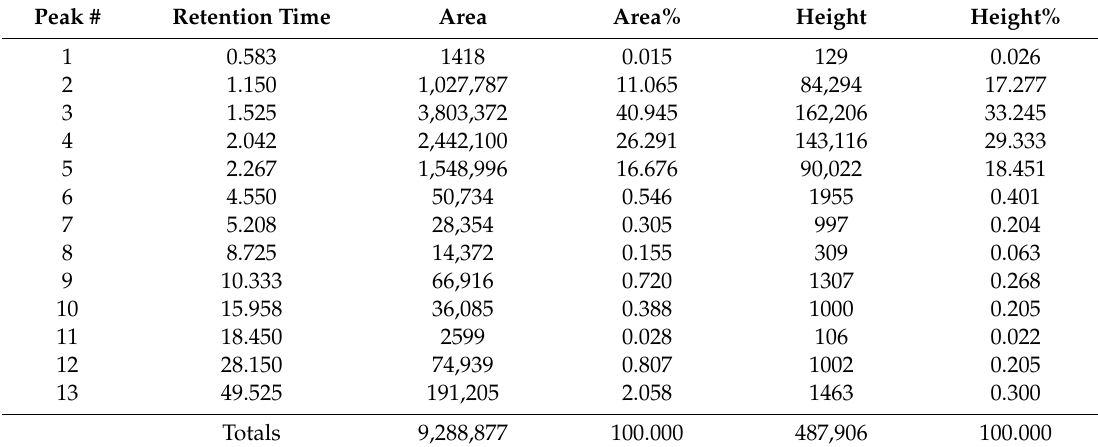
Table 3. Retention time, area, area %, height, and height % of the peaks separated by High-performance liquid chromatography / ultraviolet-visible (HPLC / UV-VIS) data of Ricinus communis leaf ethanol extract at the wavelength of 256 nm.